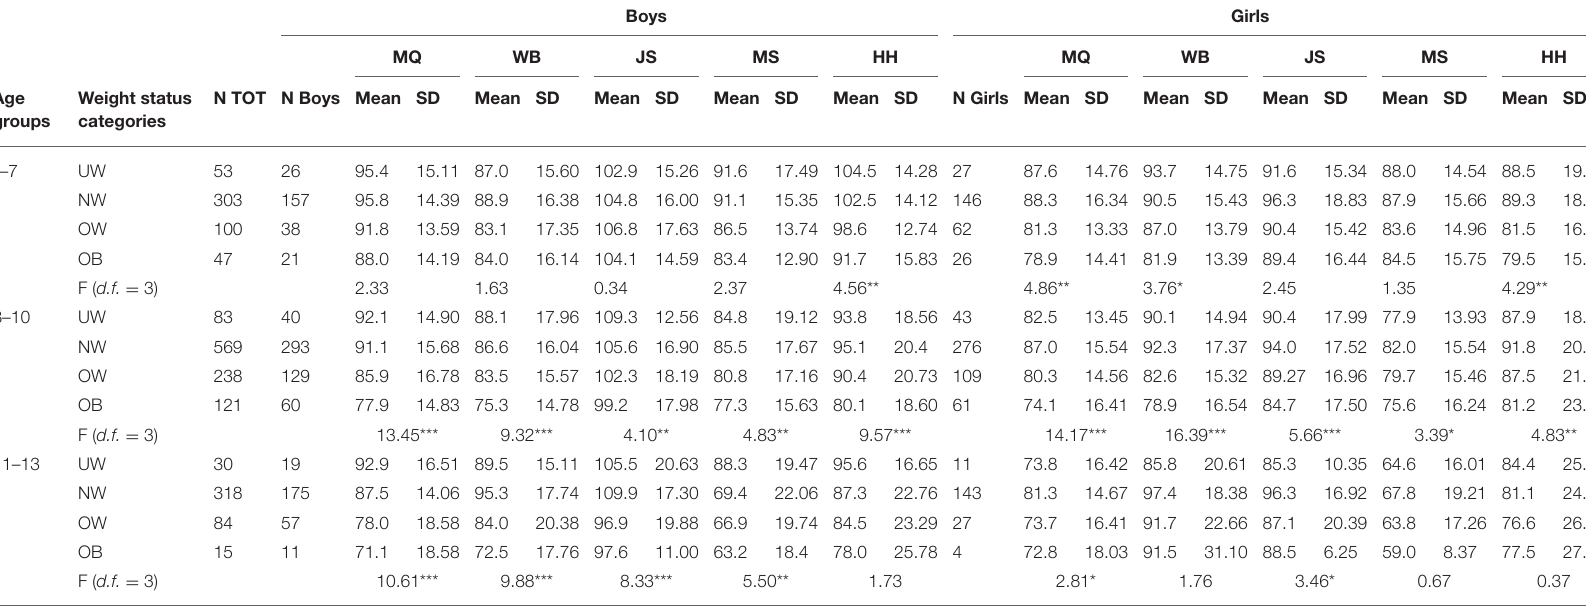
TABLE 3 | Total MQ and subtest scores of the KTK by age groups, gender classes, and weight status categories, with F -values and significance levels across the weight status categories. Boys